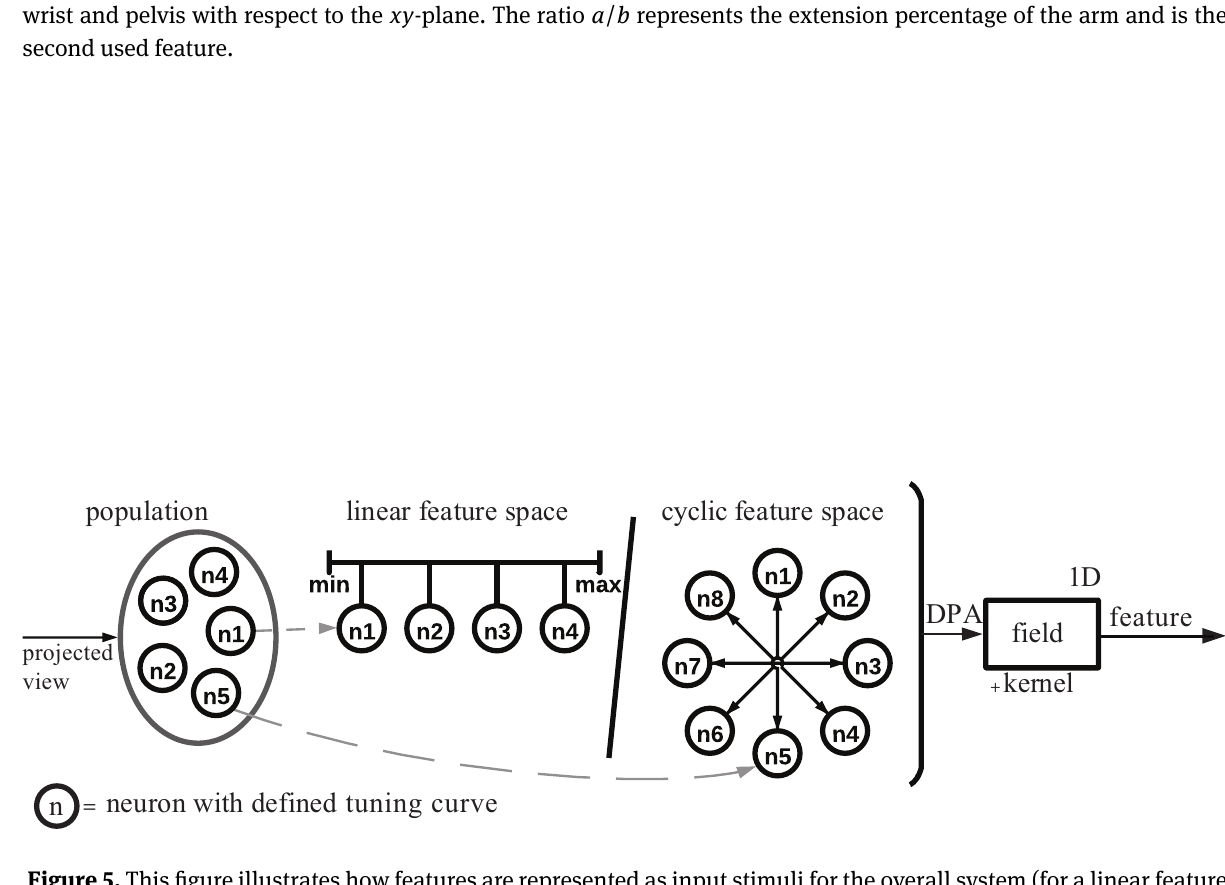
Figure 5. This figure illustrates how features are represented as input stimuli for the overall system (for a linear feature space (left) and cyclic feature space (right)). The tuning curves and optimal response values of the neurons (circles) within the population are defined. Distribution of population activation (DPA) is used to determine the population ac- tivation, which is further processed by a DNF to produce the final